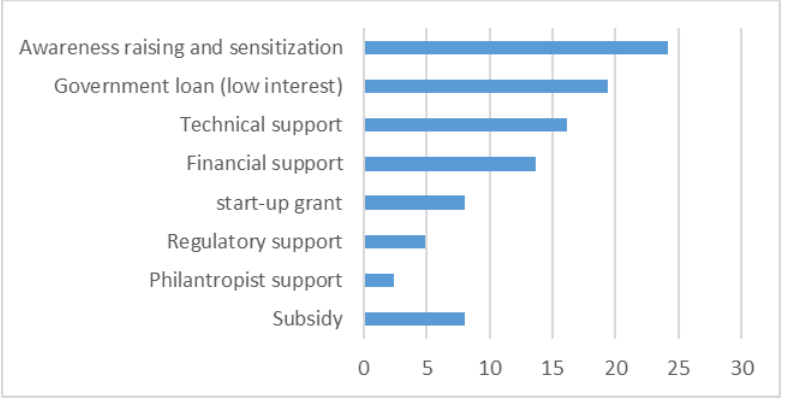
Figure 3. Perceived type of support to empower CREIs (in percentages).